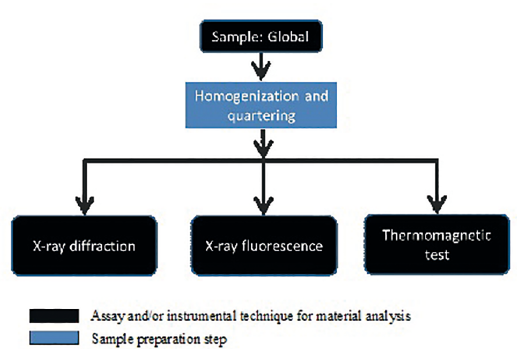
Figure 2. Flowchart of the tests and the preparation stage carried out for each